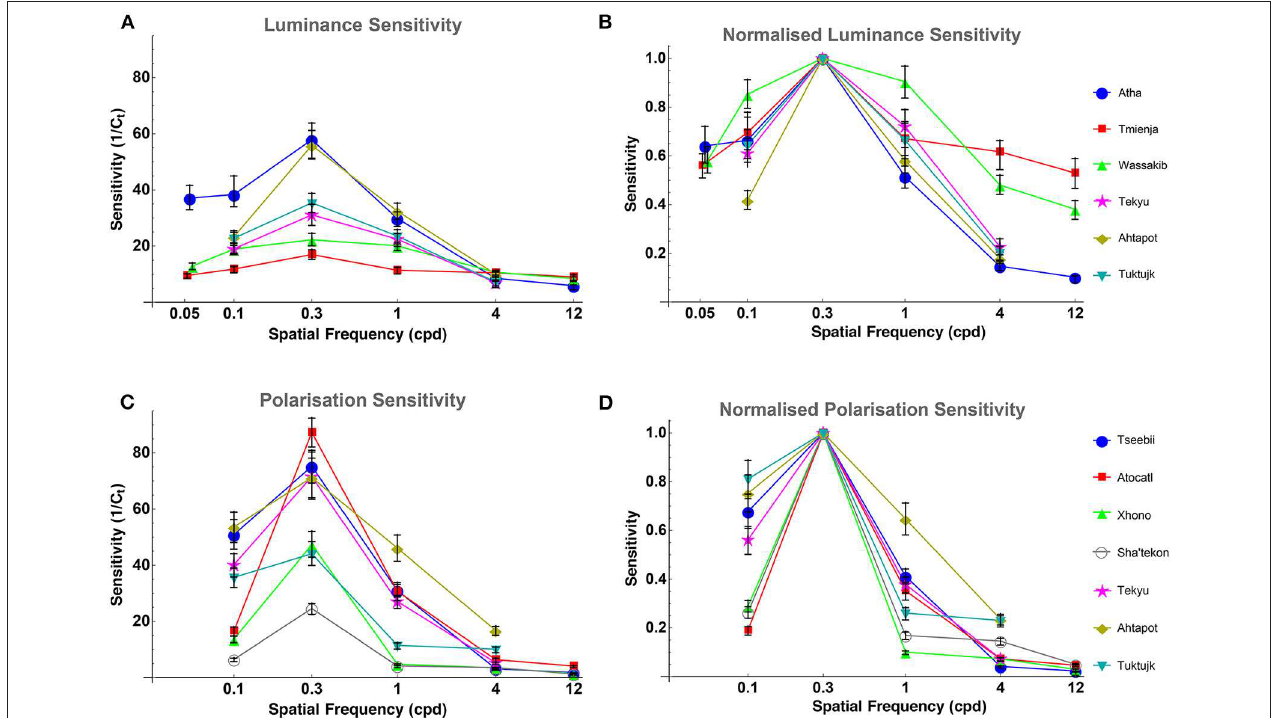
FIGURE 4 | (A) Octopus LCSF. All octopuses show the same bell-like shape of the sensitivity curve, and all peak at 0.3 cpd. Sensitivity is defined as the inverse of the contrast threshold. The error bars indicate bootstrap interquartile range. (B) Octopus LCSF normalized to the peak sensitivity value of each curve (at 0.3 cpd) for easier comparison between them. (C) Octopus PCSF. All octopuses show the same bell-like shape of the polarization sensitivity curve as the ones from the luminance sensitivity experiment. Sensitivity is defined as the inverse of the contrast of the degree of polarization. The error bars indicate bootstrap interquartile range. (D) Octopus PCSF normalized to the peak sensitivity value of each curve (at 0.3 cpd) for easier comparison between them.